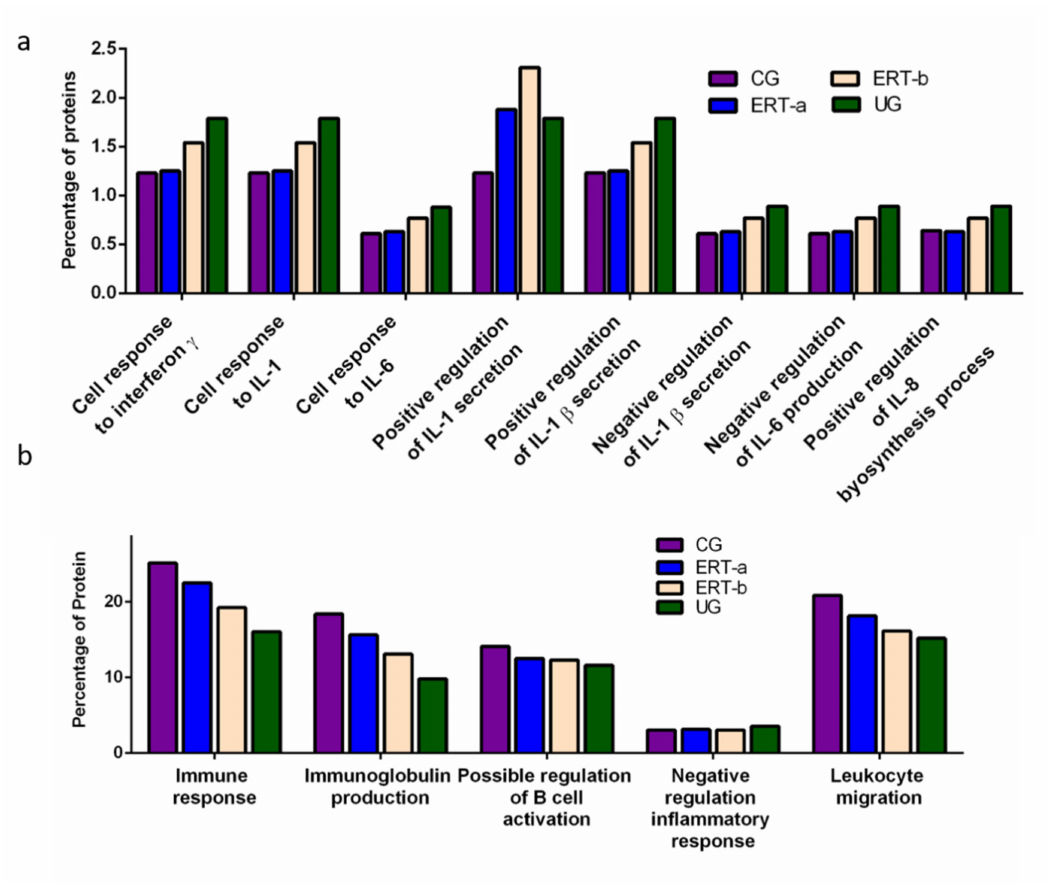
Figure 5. Functional enrichment analysis using FunRich. Proteins identified in each the different groups were submitted to molecular functional analysis according to their involvement in the immune response: proteinsrelated tointerleukins (ILs) IL-1, IL-1 β , IL-6, IL-8, and interferon γ ( a ); proteins involved in immunoglobulin production, positive regulation of B-cell activation, negative regulation of the inflammatory response, and leukocyte migration ( b